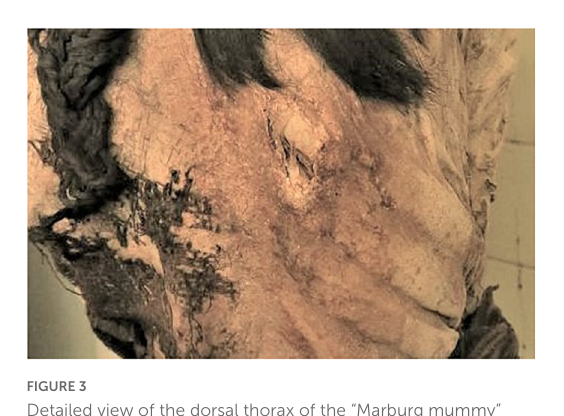
FIGURE3 Detailed view of the dorsal thorax of the “Marburg mummy” showing the defect. The margins of this defect are slightly rounded.